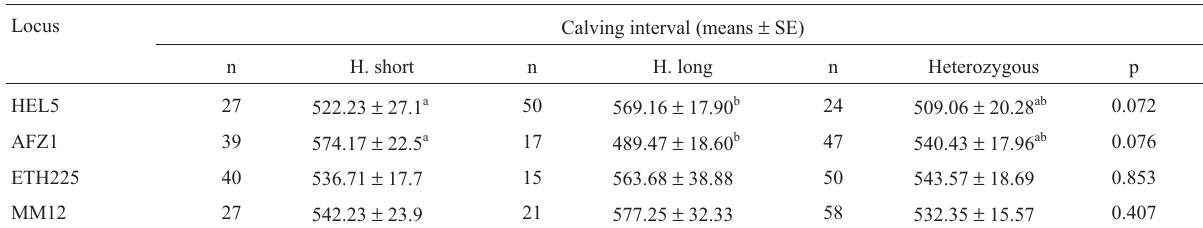
Table 3 - Results of association analyses between calving interval and microsatellite genotype classes homozygous for short (H. Short), homozygous for long (H. Long) and heterozygous. Locus Calving interval (means ± SE)